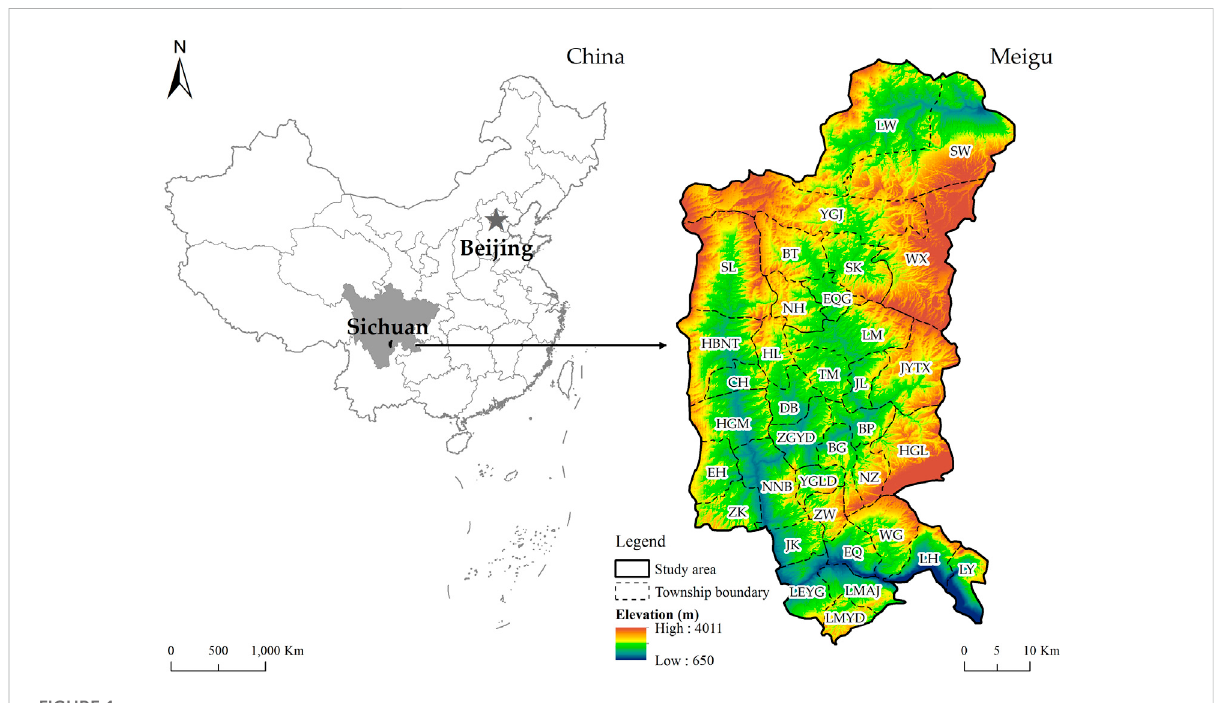
FIGURE 1 Geographic location of Meigu